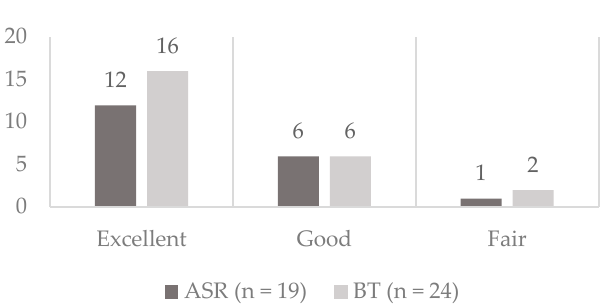
Figure 4. Results of the ASAMI functional classification in the acute shortening/relengthening (ASR) and bone transport (BT) group. There was no statistically significant difference between the groups ( p = 0.705). The y-axis gives the absolute numbers.